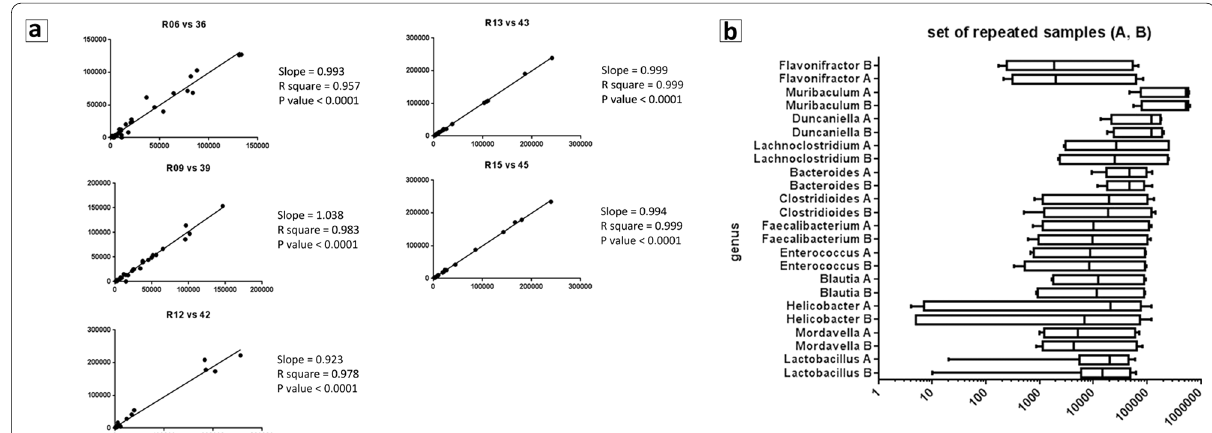
Fig. 1 Correlation analysis for each pair of 5 re-sequenced samples. a Each dot represents a species, plotted from normalized counts for sample a (X-axis) and for sample b (Y-axis) of each pair. Slope, Pearson correlation coefficient (r), and p-value are shown for each pair of samples. The values of those indexes indicate that each re-sequenced pair of samples shows significant correlation. b Top 12 genera in the mouse gut microbiota of five samples sequenced at time A and of the same samples sequenced at time B. Genera (listed in Y-axis) are depicted with boxes including 5–95% of data, median values (dark lines in the boxes). Plots are based on normalized counts (X-axis). Outcome of the analysis in the two set of samples is almost